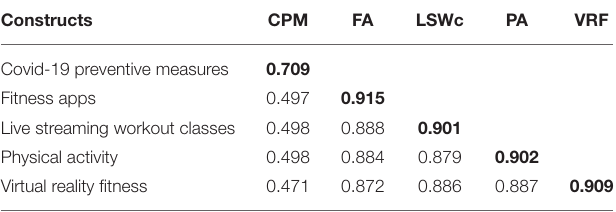
TABLE 4 | Constructs discriminant validity by following Fornell-Larcker Criteria.